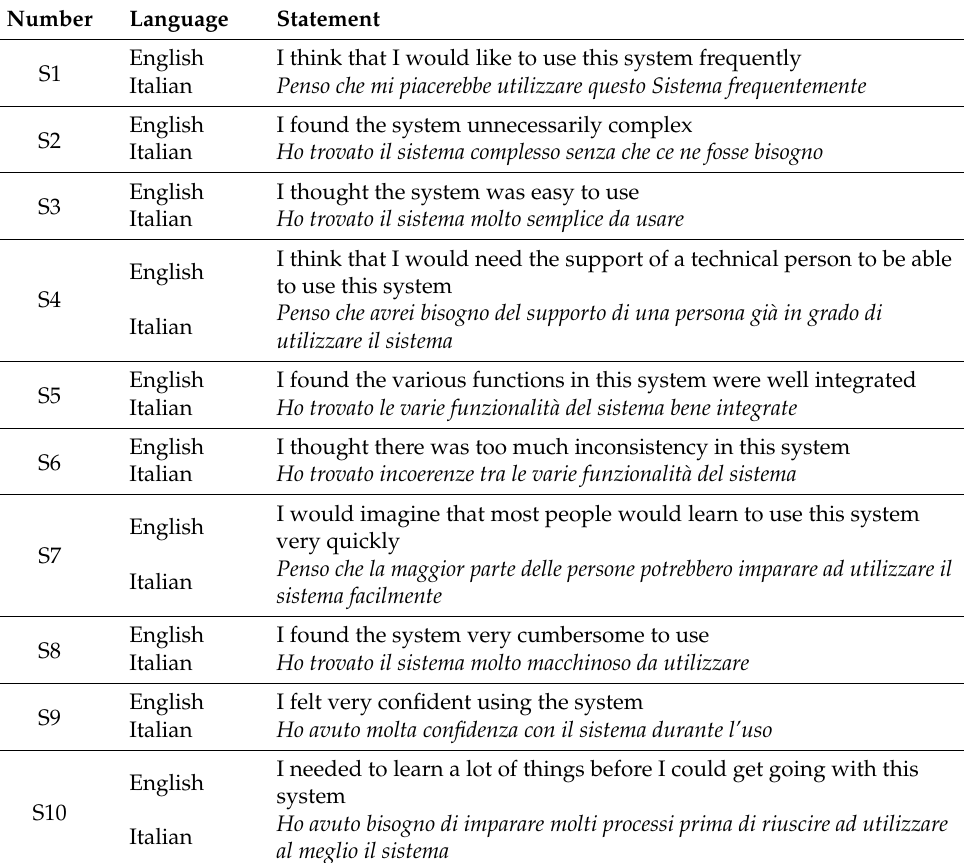
Table A1. Statements of the SUS questionnaire.